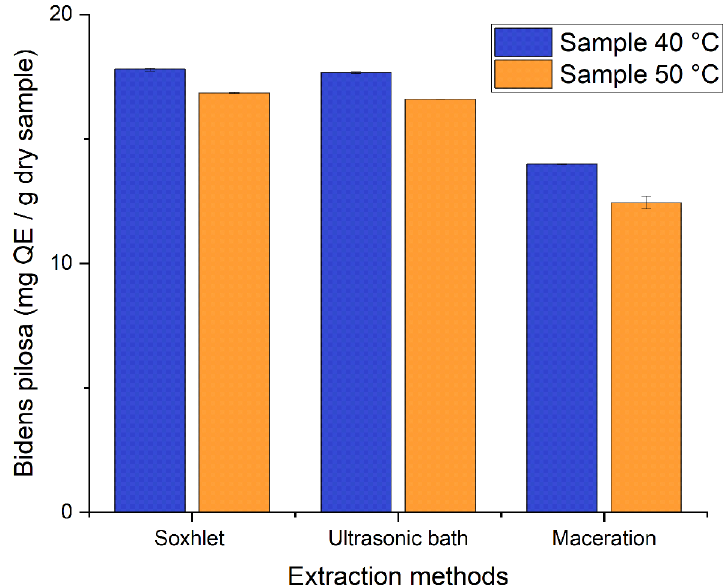
Figure 11. Total flavonoid content of the different ethanolic extracts of Bidens